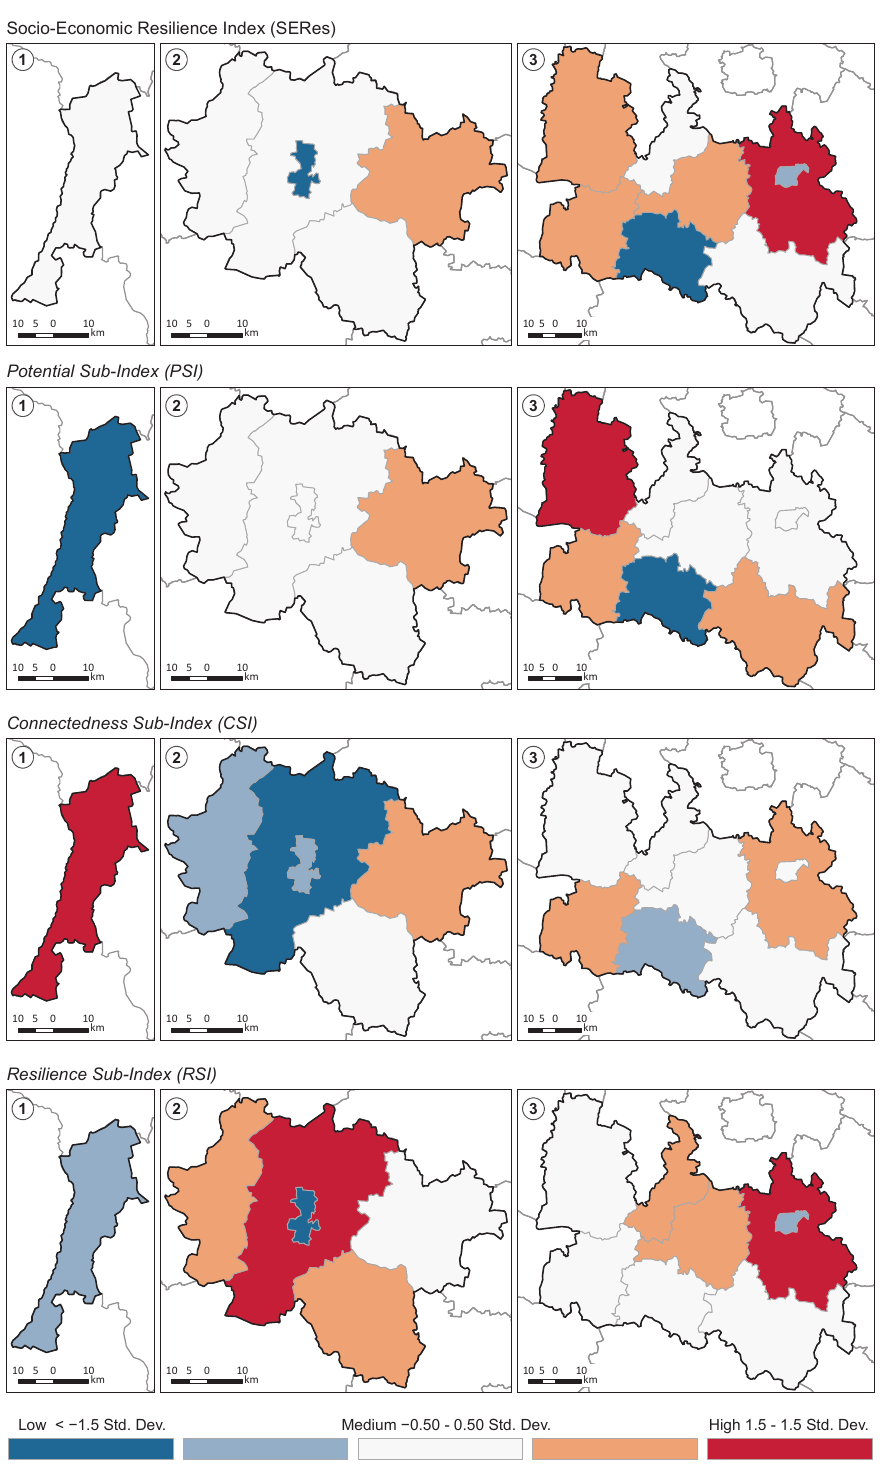
Figure 4. The Composite Socio-Economic Resilience Index (SERes) and sub-indices: PSI, CSI and RSI in the coal regions (1—the Zgorzelec region, 2—the Eastern Wielkopolska region, 3—the Łód´z